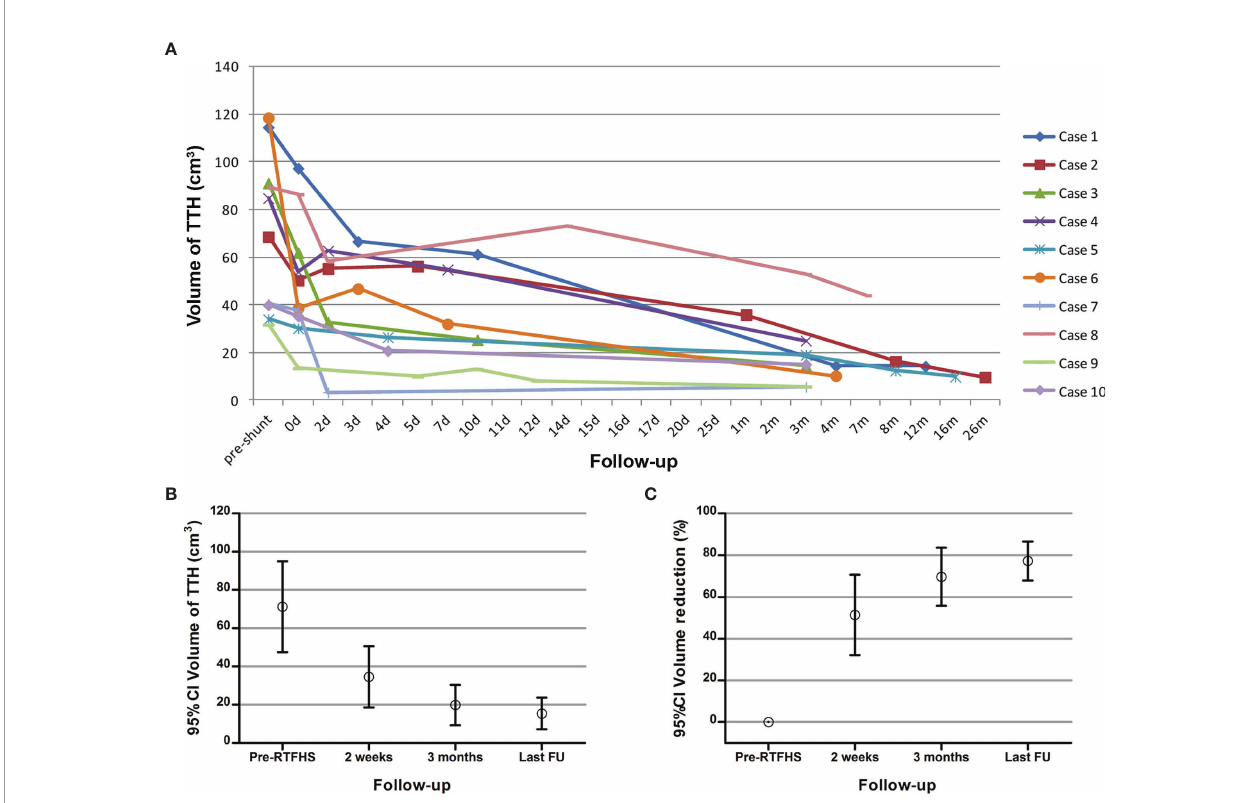
FIGURE 3 | (A) The volume curve of the TTH from each patient during the follow-up. (B, C) The mean TTH volume and the mean reduction of TTH volume before shunt, at 2 weeks, at 3 months, and at last